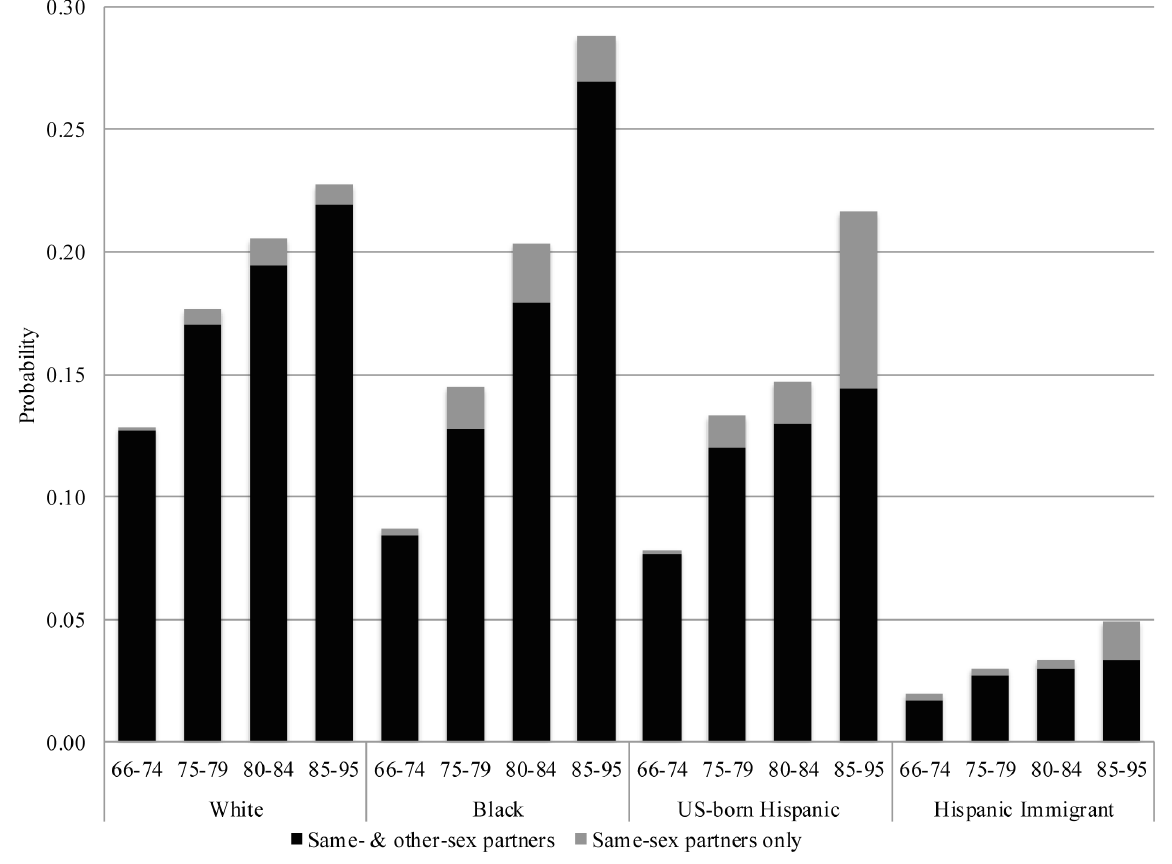
Figure 3: Women’s predicted probability of having had sex with same-and other-sex partners, by birth cohort and